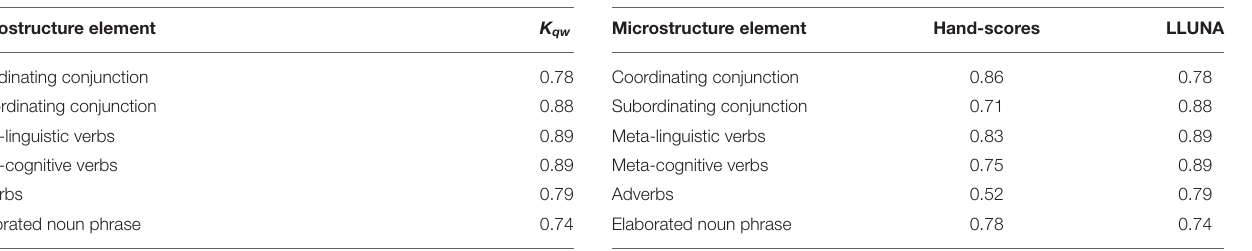
TABLE 4 | K qw for hand-scores against